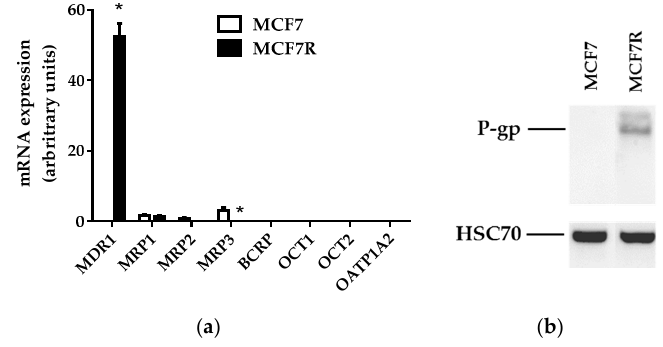
Figure 1. MDR1 mRNA and P-gp expression in MCF7 and MCF7R cells. ( a ) Drug transporter mRNA expression determined by RT-qPCR. Data are expressed as arbitrary units and are the means ± SEM of three independent assays. *, p < 0.05 when compared to transporter mRNA expression found in MCF7 cells. ( b ) P-gp expression analyzed via Western blot. Data shown are representative of three independent assays.